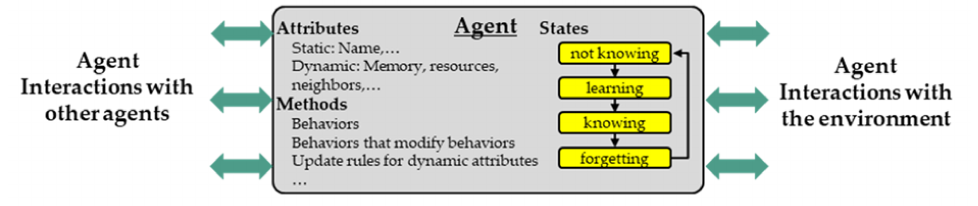
Figure 4. Typical agent structure and interactions (following